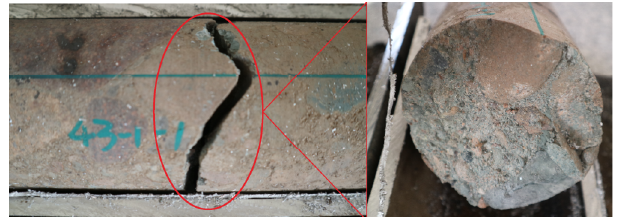
Figure 8. Features of a core cutting-induced fracture.